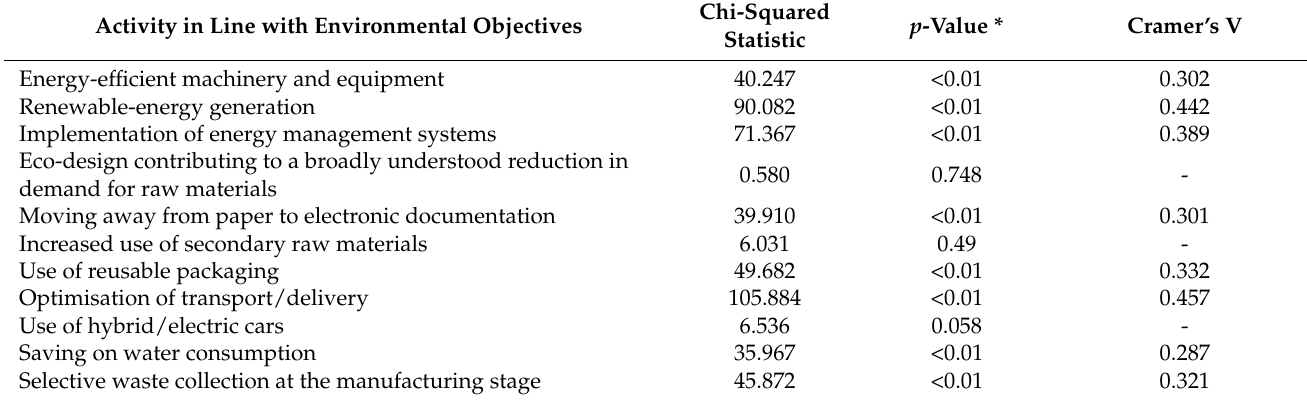
Table 5. Results of a chi-squared test for the relationship between the status of implementation of measures in an enterprise in line with environmental objectives and the size of the